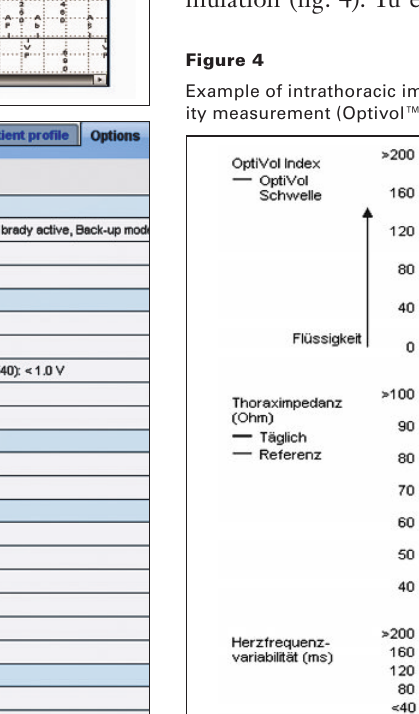
Example of intrathoracic impedance and heart rate variabil- ity measurement (Optivol™,